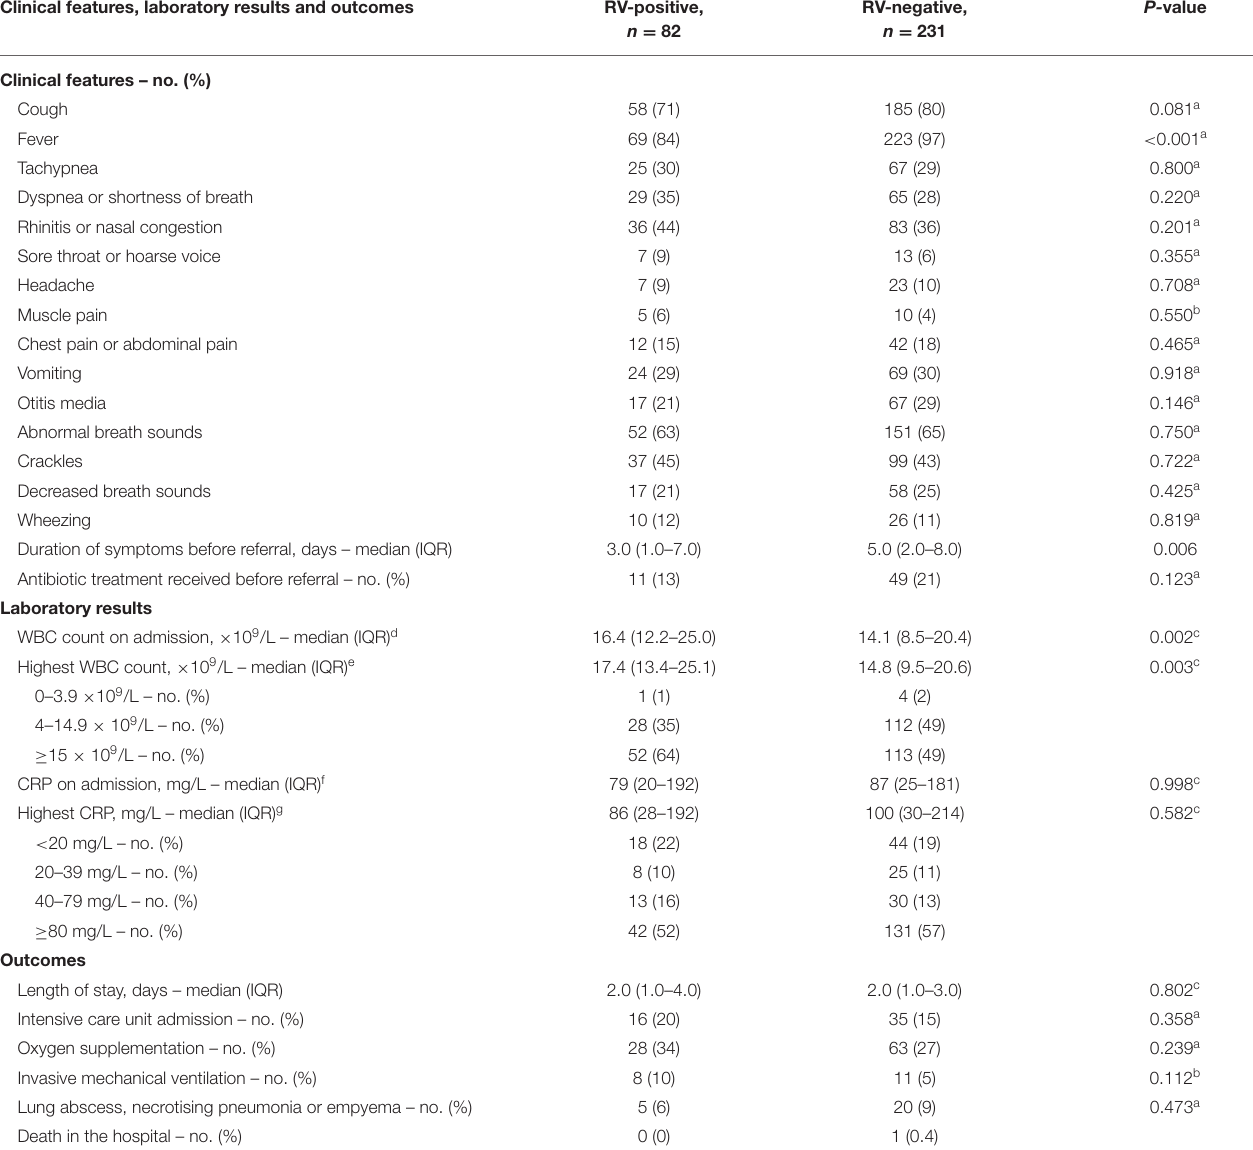
TABLE 2 | Clinical features, laboratory results and outcomes of children with community-acquired pneumonia requiring hospitalization; RV-positive patients compared to RV-negative patients. Clinical features, laboratory results and outcomes RV-positive,